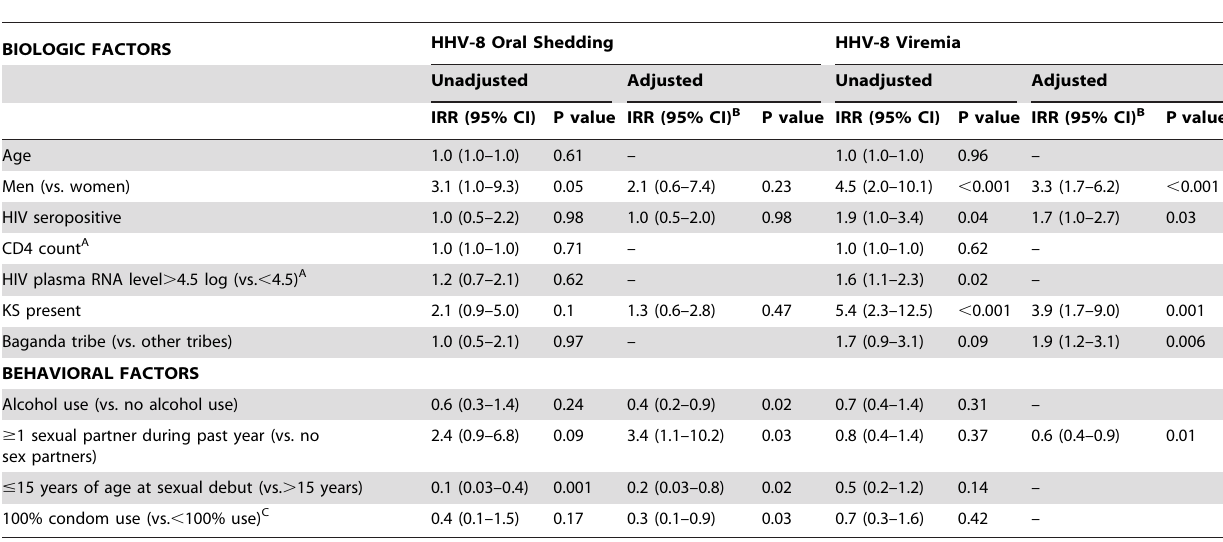
Abbreviations: IRR=incidence rate ratio, CI=confidence interval, vs=versus. A Calculated for HIV seropositive participants only. B Multivariate model, adjusted for other variables indicated in table. C Data missing for 2